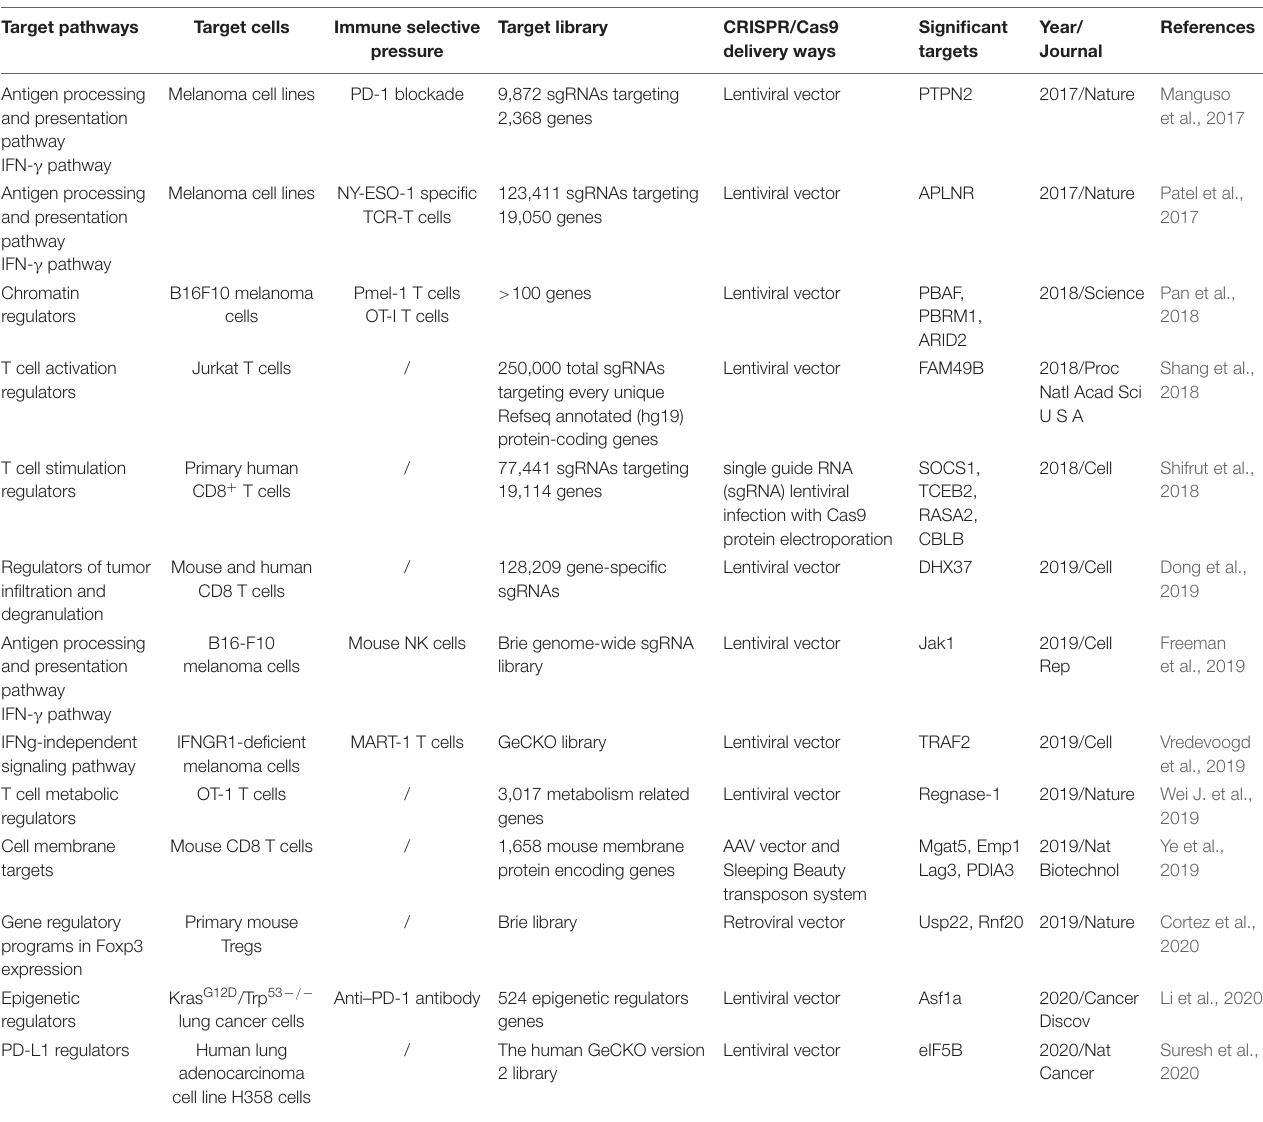
TABLE 3 | Summary of new targets identified by CRISPR/Cas9